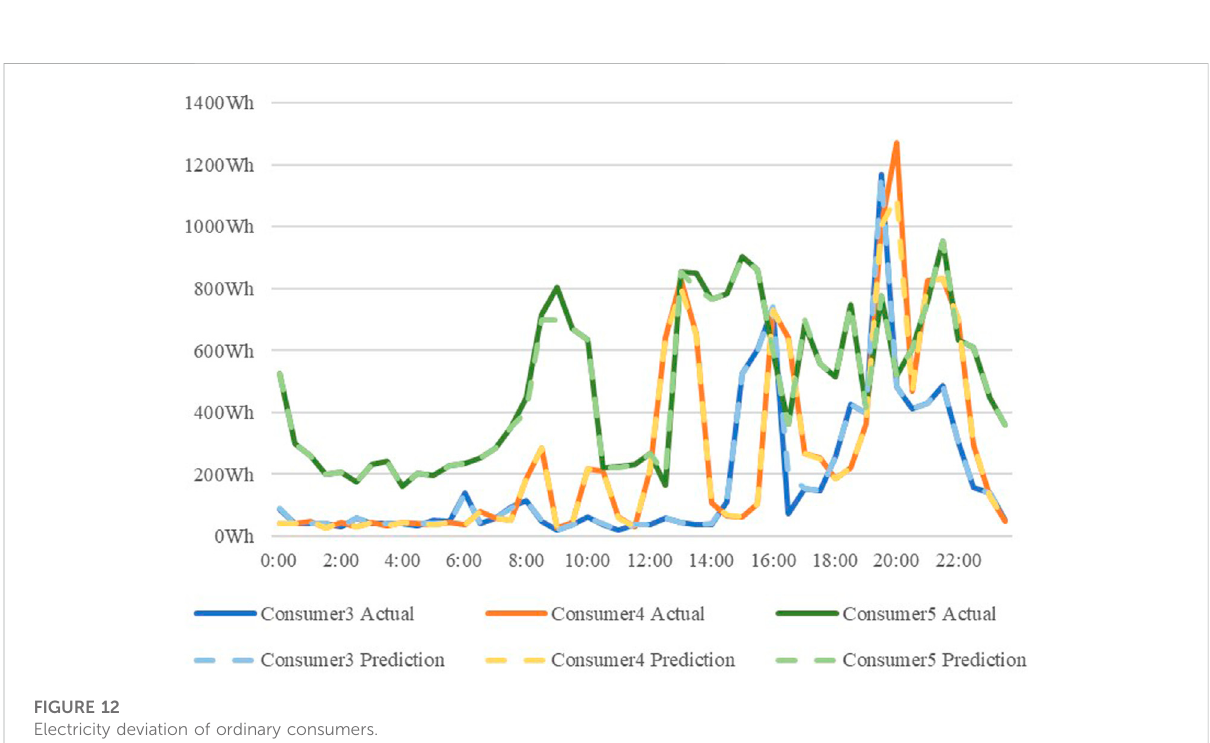
FIGURE 12 Electricity deviation of ordinary